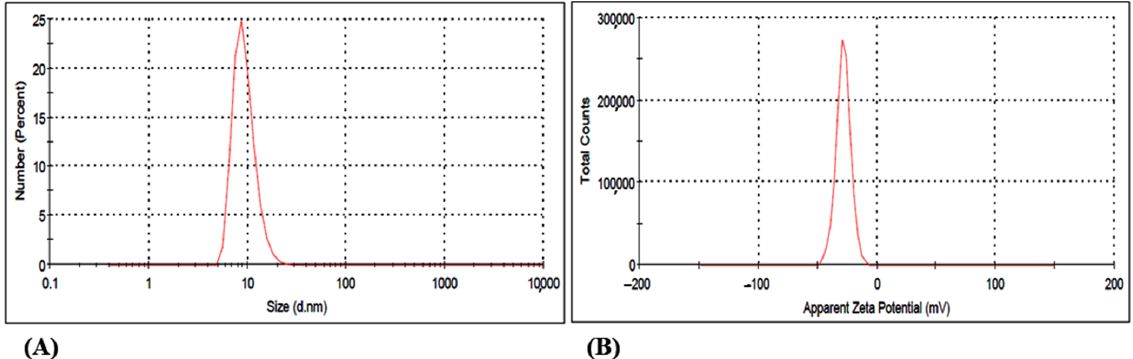
Figure 4. Dynamic light scattering study representing ( A ) size distribution (Average size − 45.53 nm) and ( B ) zeta potential ( − 28.2).